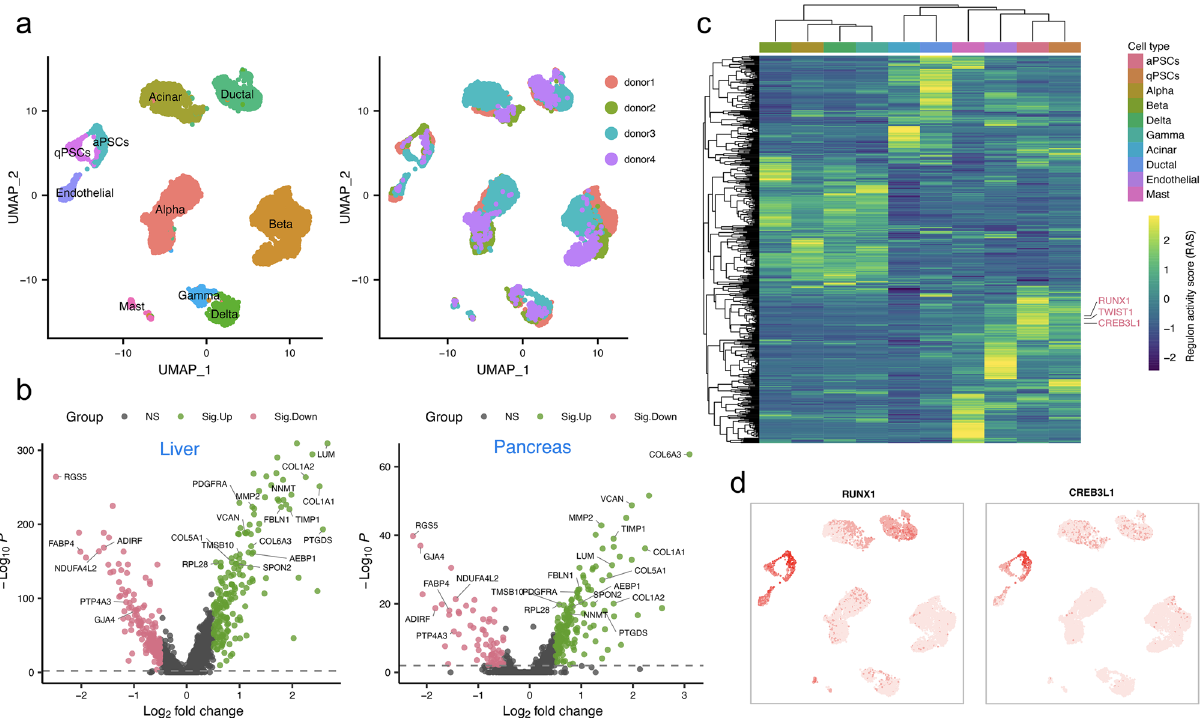
Figure 4. Comparison of expression patterns between hepatic and pancreatic stellate cells. ( a ) UMAP embedding of human pancreatic cells retrieved from Baron et al. (2016). Left, cells colored by cell type. Right, cells colored by donor. qPSCs, quiescent PSCs; aPSCs, activated PSCs. ( b ) Volcano plot of differential gene expression analysis between activated and quiescent stellate cells for liver (left) and pancreas (right). Significantly upregulated (Sig.Up) and downregulated (Sig.Down) genes in activated stellate cells are shown in green and pink, respectively. 16 and 6 genes shared among the top 50 up- or down-regulated genes between liver and pancreas are labelled, respectively. ( c ) Heatmap of the inferred regulons for human pancreatic cells. ( d ) Regulon activity based UMAP colored according to the regulon activity of CREB3L1 and RUNX1 showing the cell type specificity of